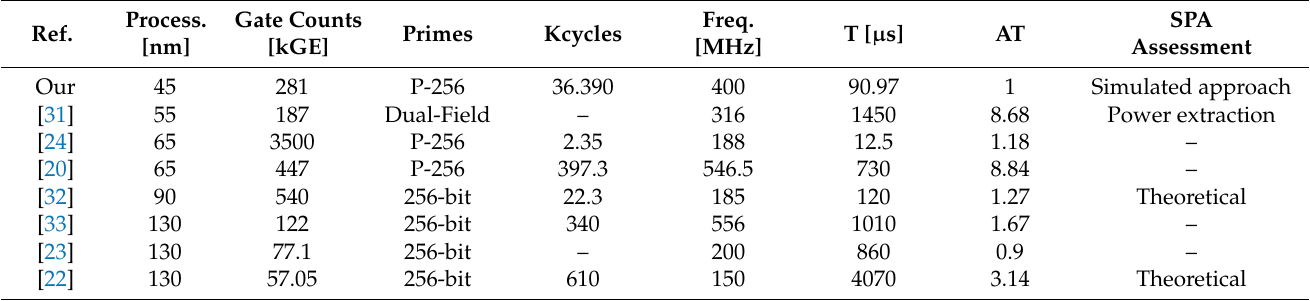
Table 6. Comparison among previous works for 256-bit